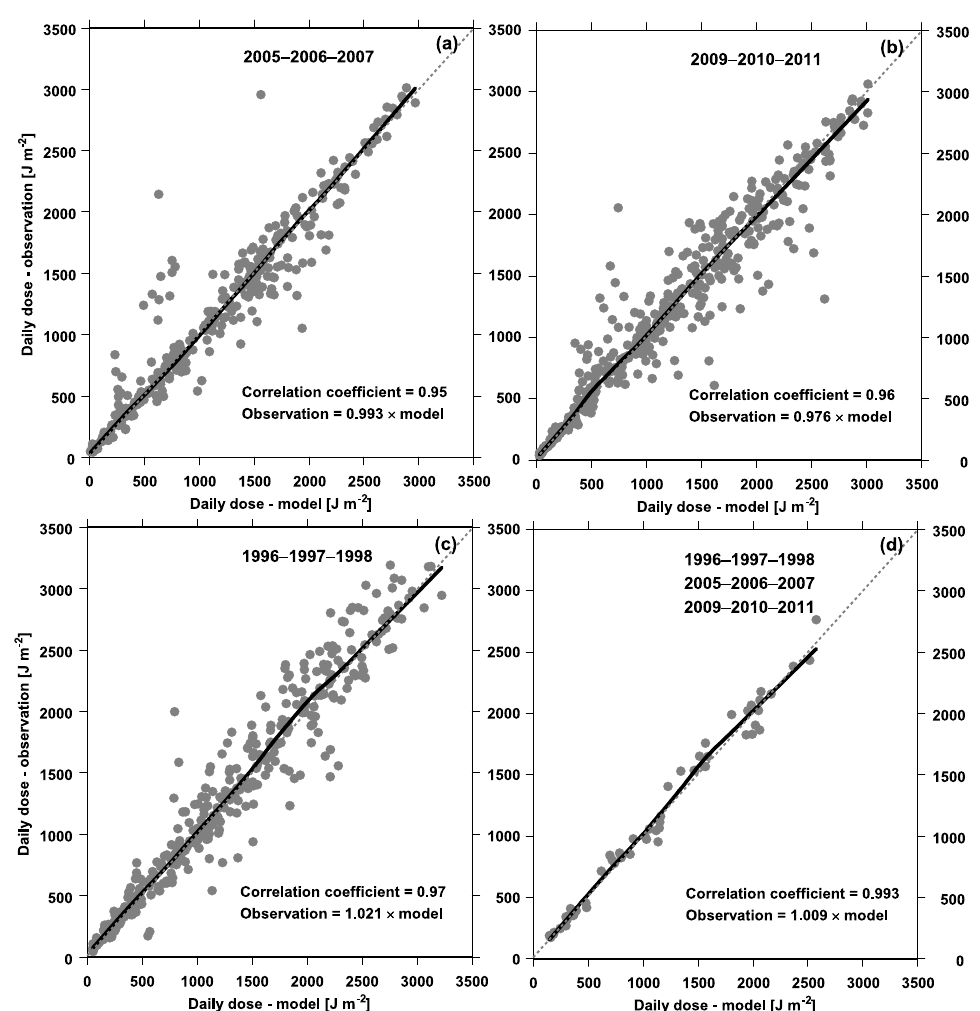
Figure 5. The observed versus modeled erythemal doses: (a) daily doses for the period 2005–2006–2007, (b) daily doses for the period